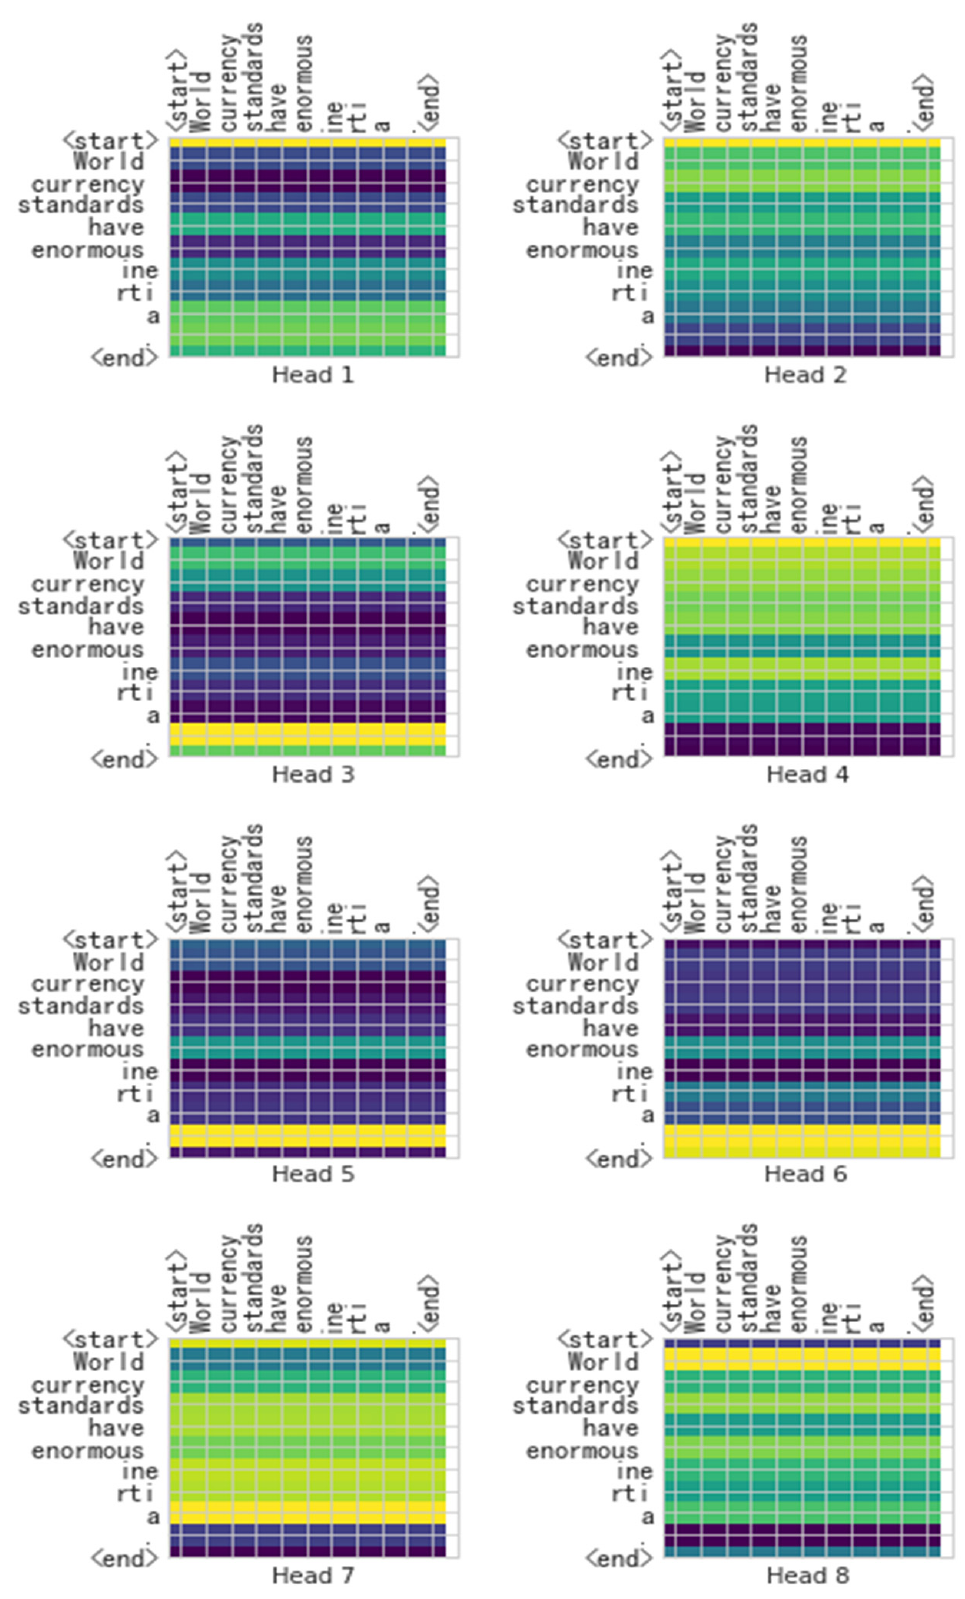
Figure 7. Heat maps of the sentence “World currency standards have enormous inertia” obtained with the Transformer.